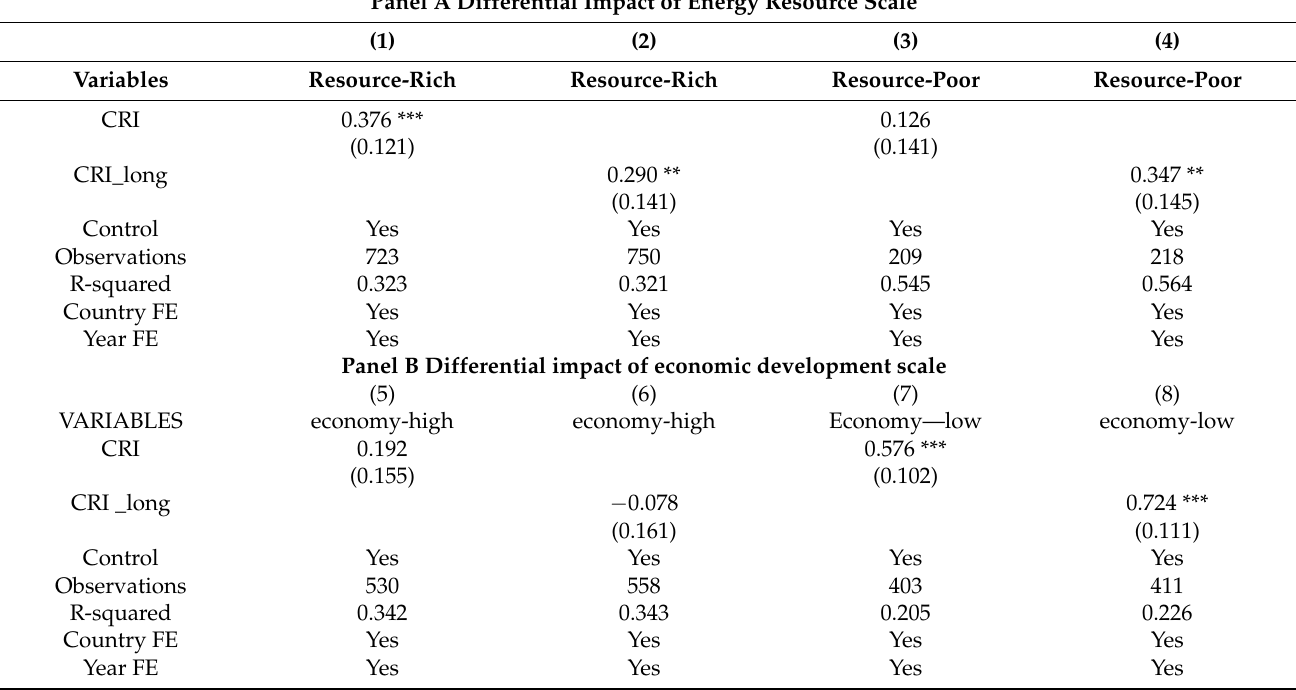
Table 8. Estimation results of the heterogeneity